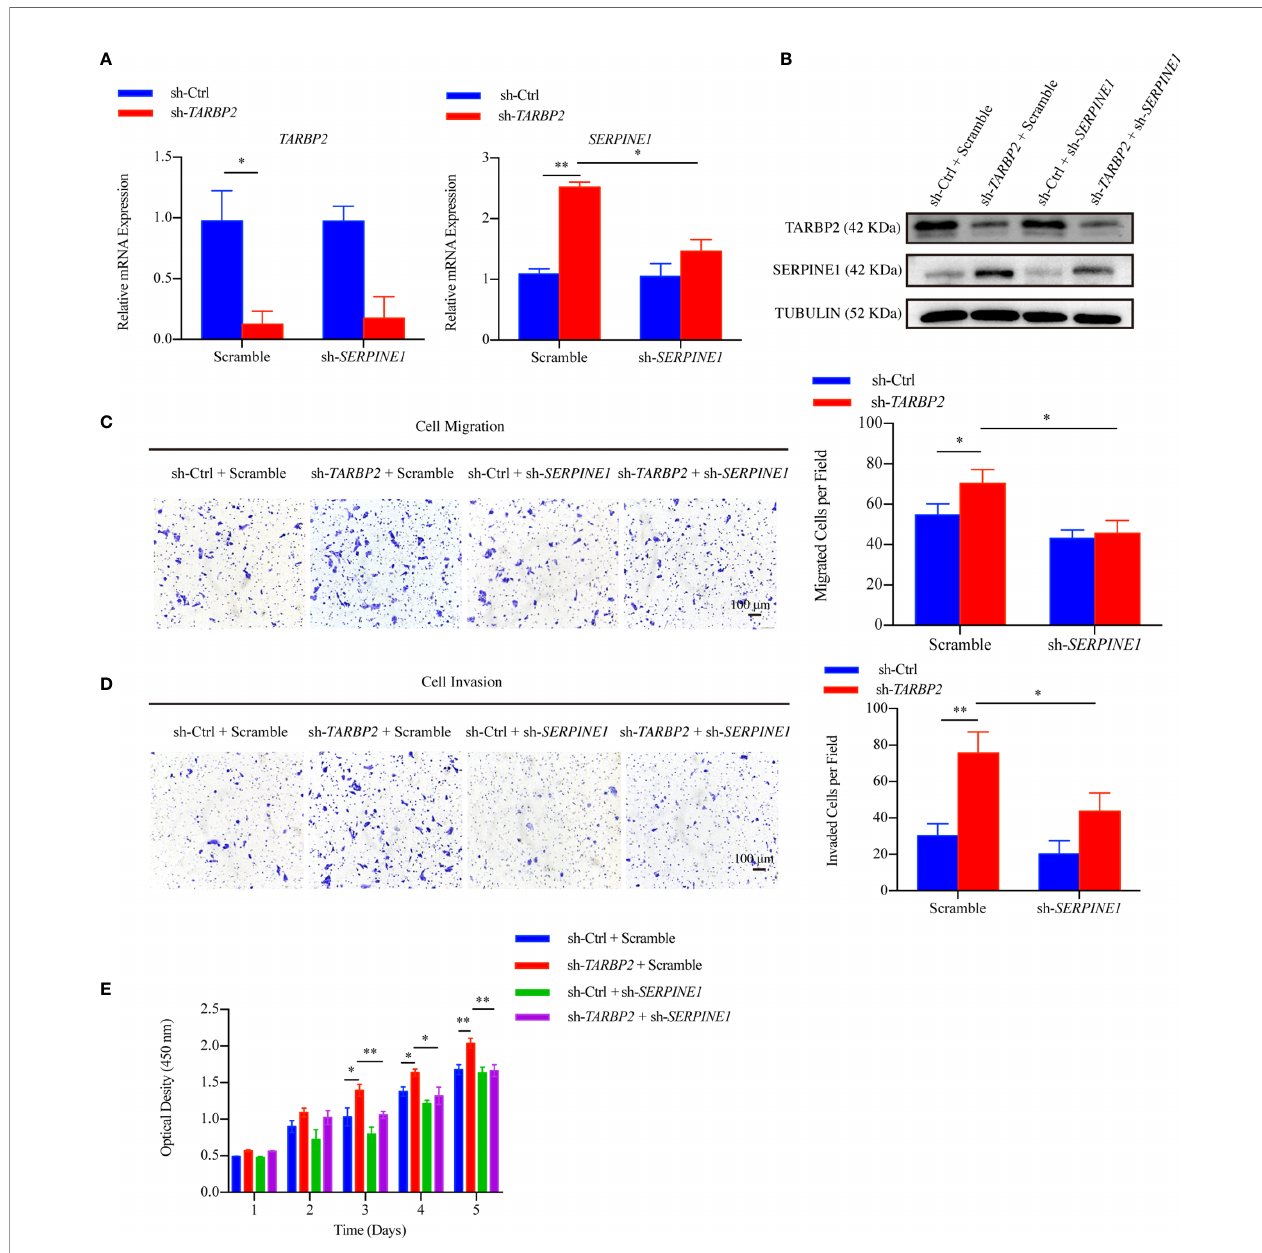
FIGURE 5 | SERPINE1 is a downstream player of TARBP2. (A, B) The mRNA and protein expression of TARBP2 and SERPINE1 in the stable sh-TARBP2 HepG2 cells after treatment with scramble control and sh-SERPINE1. (C) Cell migration; (D) Invasion; and (E) Proliferation assays of sh-TARBP2 HepG2 cells treated with scramble control and sh-SERPINE1. *p-value < 0.05; **p-value <